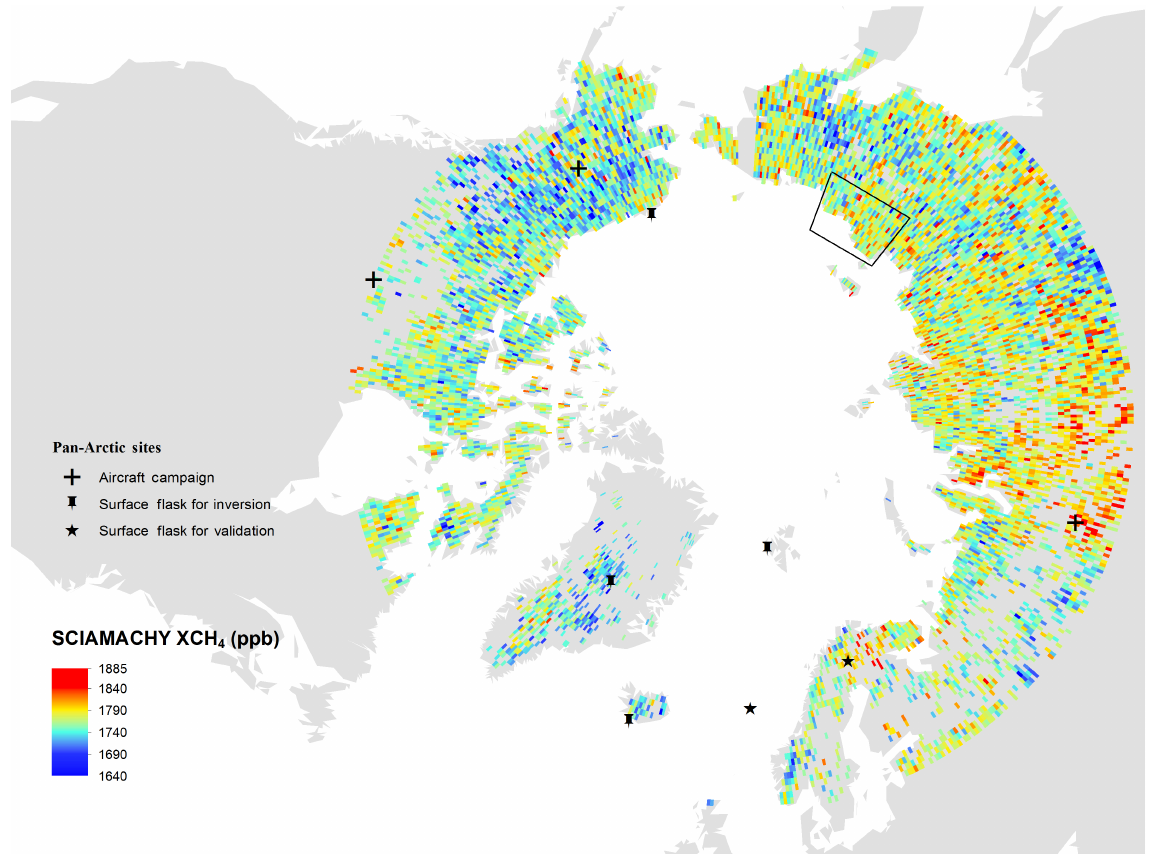
Figure 1. SCIAMACHY retrievals ( n = 37743) of the weighted column-average CH 4 dry-mole fractions for July–September 2005 in the pan-Arctic that have passed all quality control tests described in Sect. 2.1, and the locations of surface flask stations and aircraft missions used for data assimilation or inversion